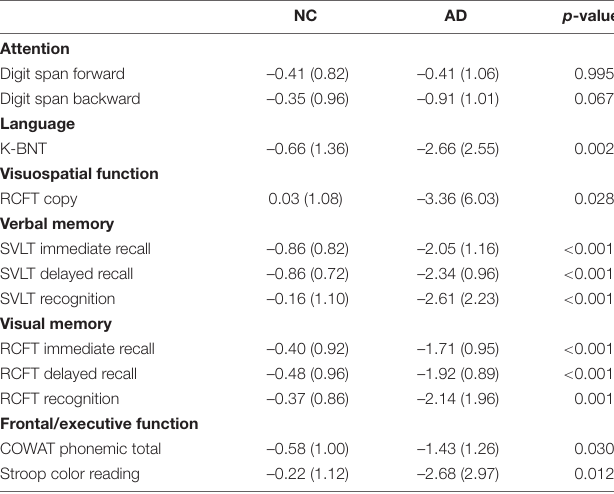
TABLE 3 | Neuropsychological performance in the NC and AD